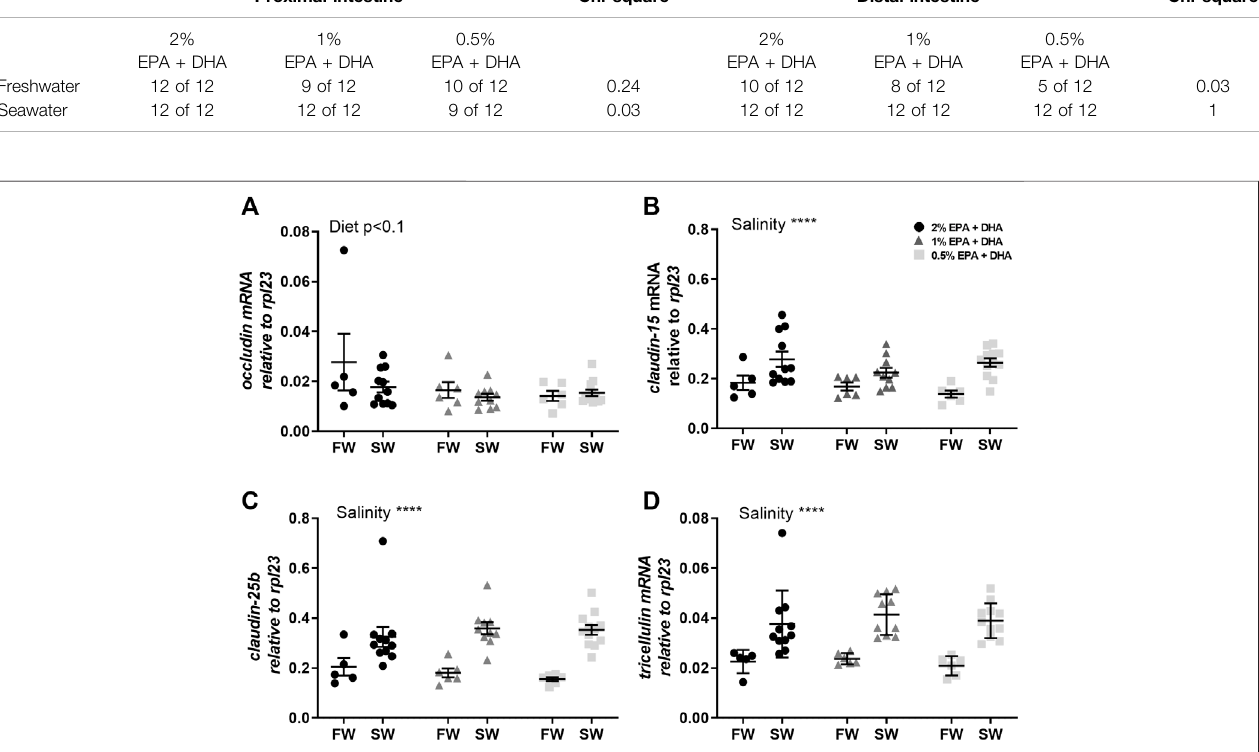
FIGURE3| Transcriptlevelsof (A) occludin , (B) claudin-15 , (C) claudin-25b and (D) tricellulin intheproximalintestineoffreshwater(FW)smoltsandseawater(SW) acclimatedAtlanticsalmonfeddifferentlevelsofomega-3.Statistics:two-wayANOVA.Signi fi canteffectsarereportedas* p < 0.05and*** p < 0.001.Dataarepresented as individual values with the horizontal line representing the mean and the vertical lines